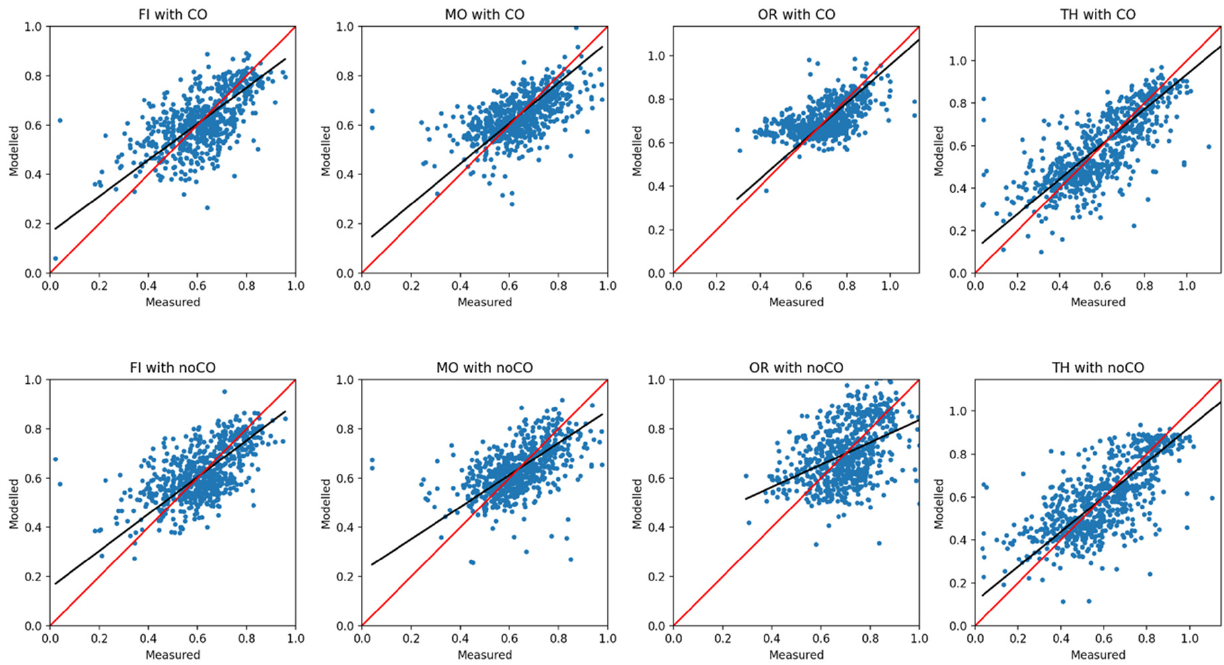
Figure 12. Linear regression model for all stations (CS, CH, FI, FR, MO, OR, TH) without WD and WS.